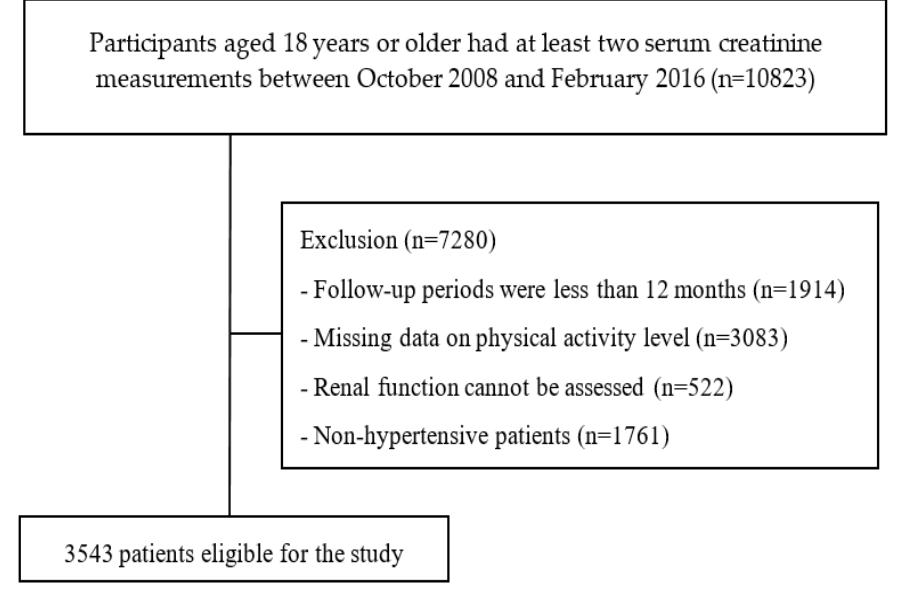
Figure 1. Flowchart of participant analyzed in this study.